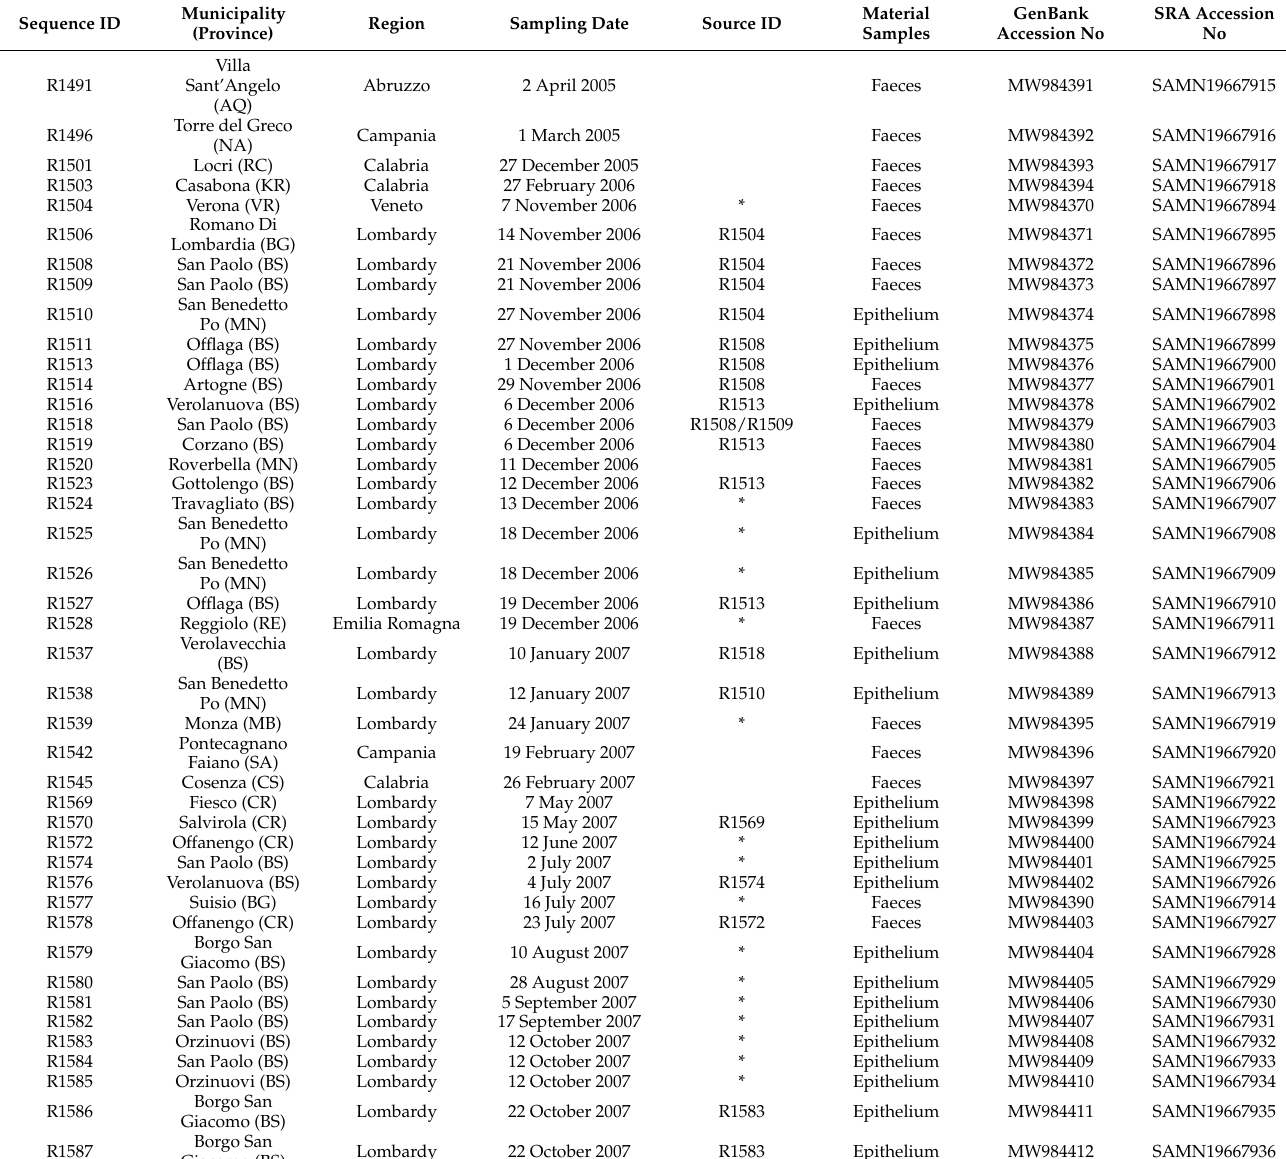
Table 1. Epidemiological data extracted for each of the SVDV isolates analysed in this study and collected during veterinary field investigations from each of the farms affected by the 2006–2007 SVD